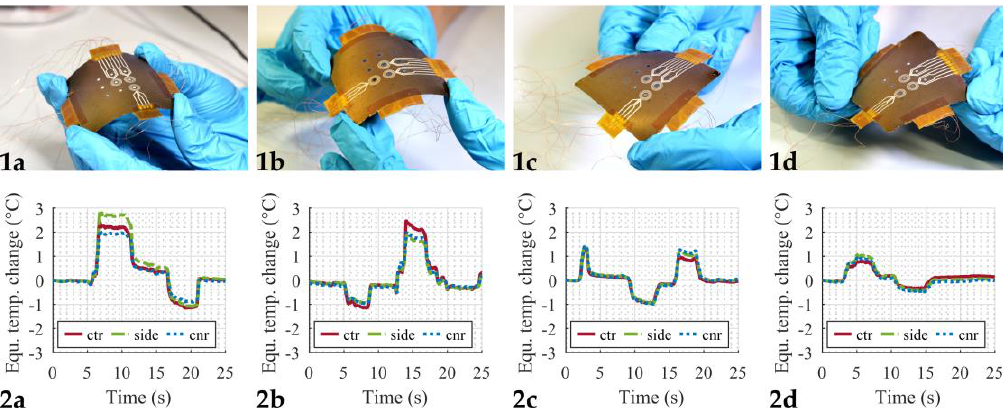
Figure 7. Bending tests. ( 1a – 1d ) Pictures of the manually applied deformation of the dosage plate. ( 2a – 2d ) Equivalent temperature change caused by bending, calculated from the resistance change of the RTDs. Legend: Solid red lines correspond to the center position (ctr), dash-dotted green lines to the side position (side), and dotted blue lines to the corner position (cnr).